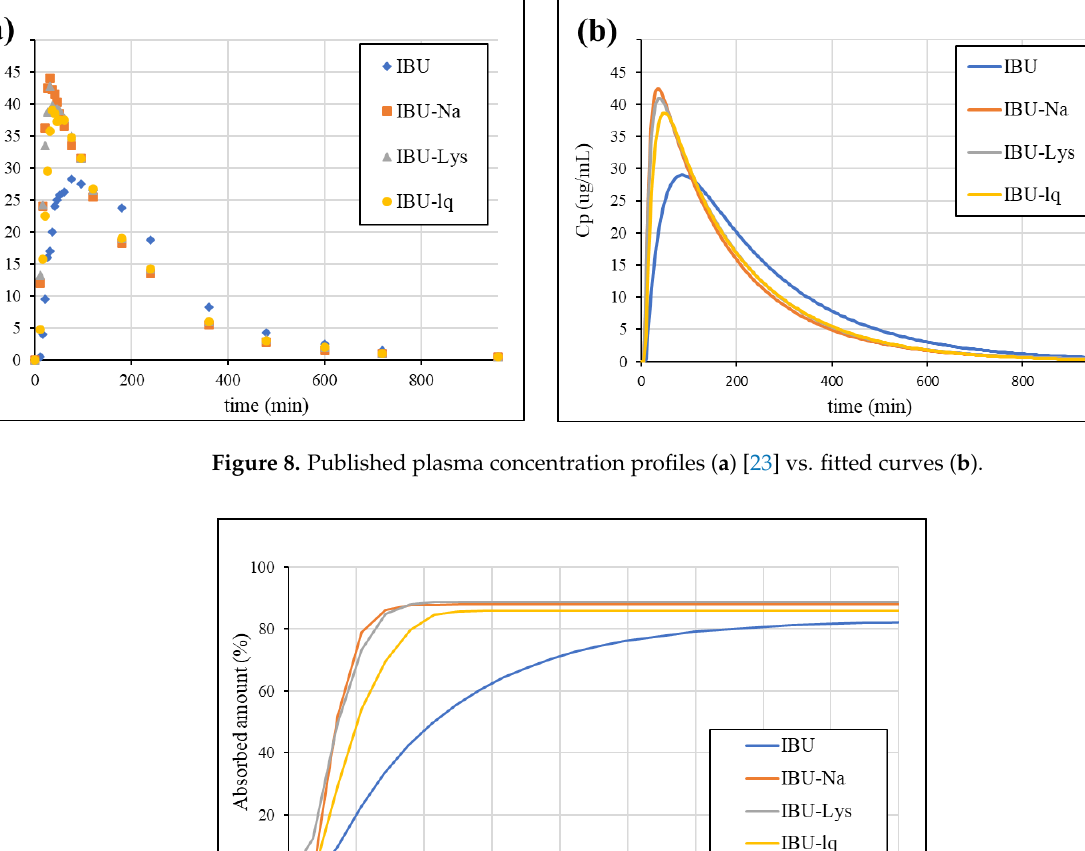
Figure 9. Absorption profiles obtained by deconvolution of clinical data [23].